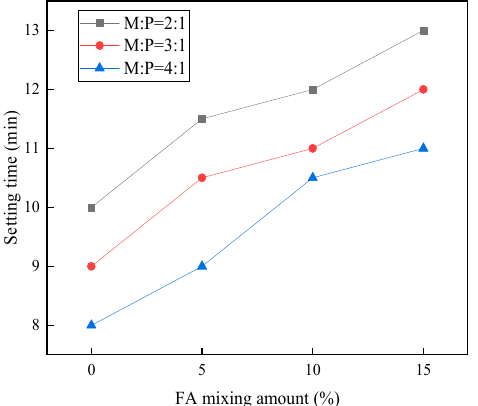
Figure 4. Setting time under different fly ash dosing.